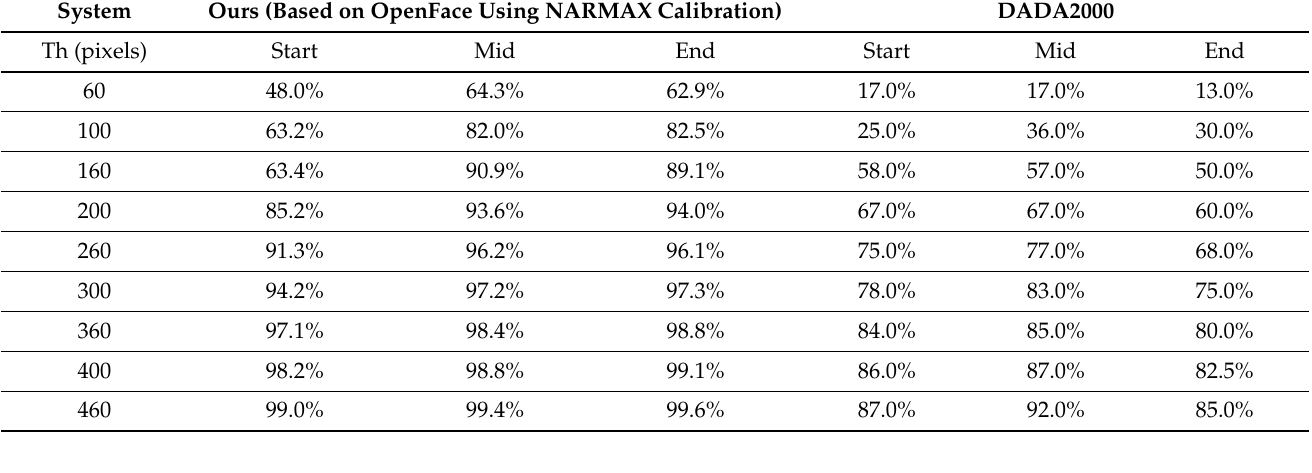
Table 6. Frame ratio: percentage of frames in each clip section where the attention point is inside the correct detection area. This is measured frame by frame because the crash object change with it.